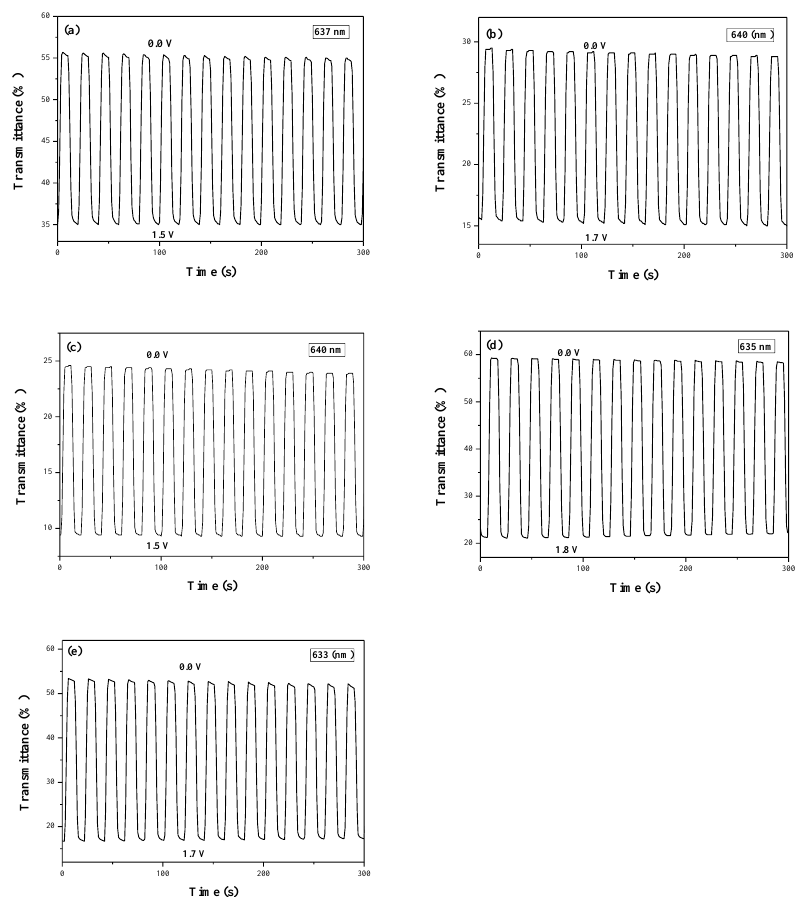
Figure 8. Optical contrast of ( a ) PDiCP/PEDOT-PSS; ( b ) P(DiCP- co -CPDT)/PEDOT-PSS; ( c ) P(DiCP- co -CPDT2)/PEDOT-PSS; ( d ) P(DiCP- co -CPDTK)/PEDOT-PSS; and ( e ) P(DiCP- co -CPDTK2)/PEDOT-PSS ECDs with a residence time of 10 s. Table 6. Optical and electrochemical properties investigated at the selected applied wavelength for the devices.